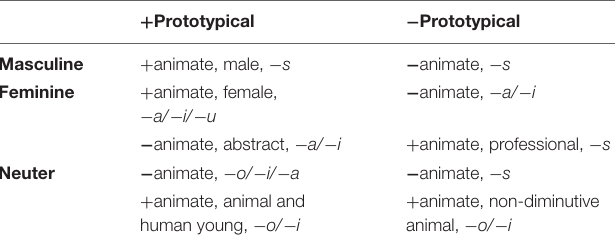
TABLE 4 | Overview of the Greek prototypicality categories according to Anastasiadi-Symeonidi and Cheila-Markopoulou